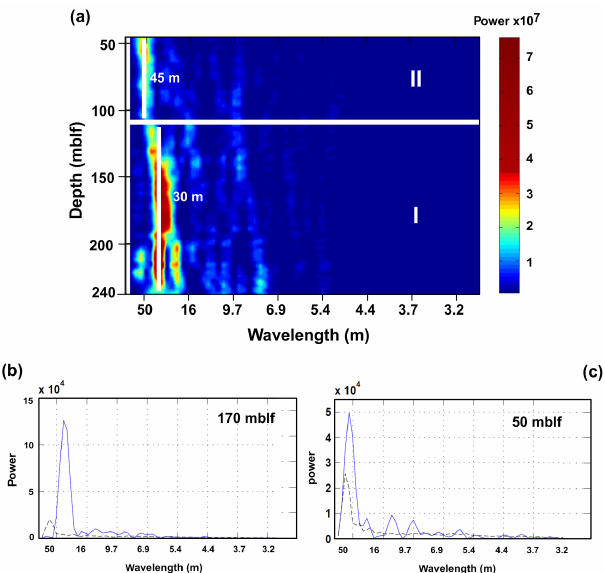
Figure 3. (a) Three-dimensional spectrogram from sliding window analysis of GR data from 0 to 240mb.l.f. The relative power of the frequency components is indicated by colour and two spectral peaks with wavelengths of 30 and 45m are apparent. Based on the break in the spectral characteristics at about 110mb.l.f., the spectral plot was subdivided into a lower interval I (240 to 110mb.l.f.) and an upper interval II (110 to 0mb.l.f.). Single spectra of GR from interval I at 170mb.l.f. (b) and from interval II at 50mb.l.f. (c) are displayed below and show that the wavelengths of 30 and 45m are prominent. The dashed line separates the spectral background from the spectral